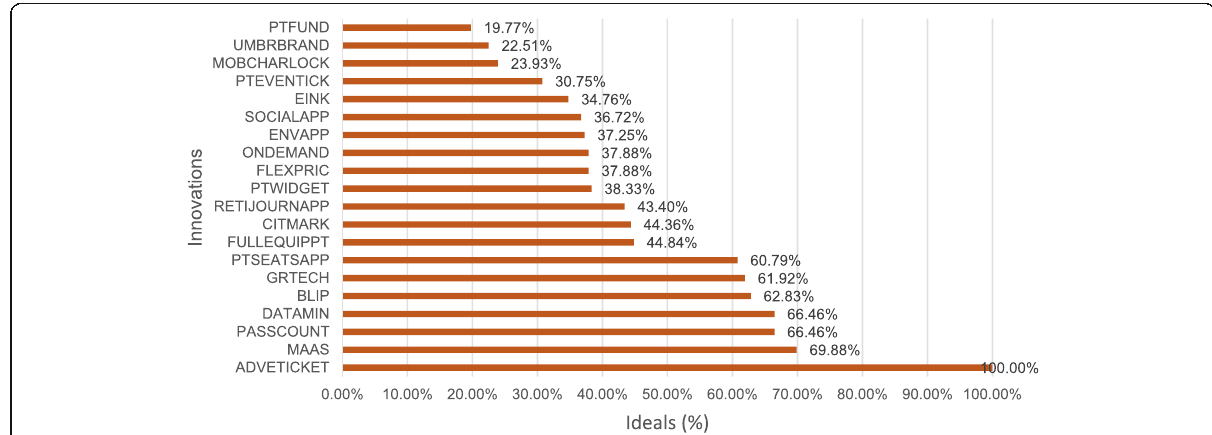
Fig. 6 Ranking of innovations with respect to Innovativeness (Ideals